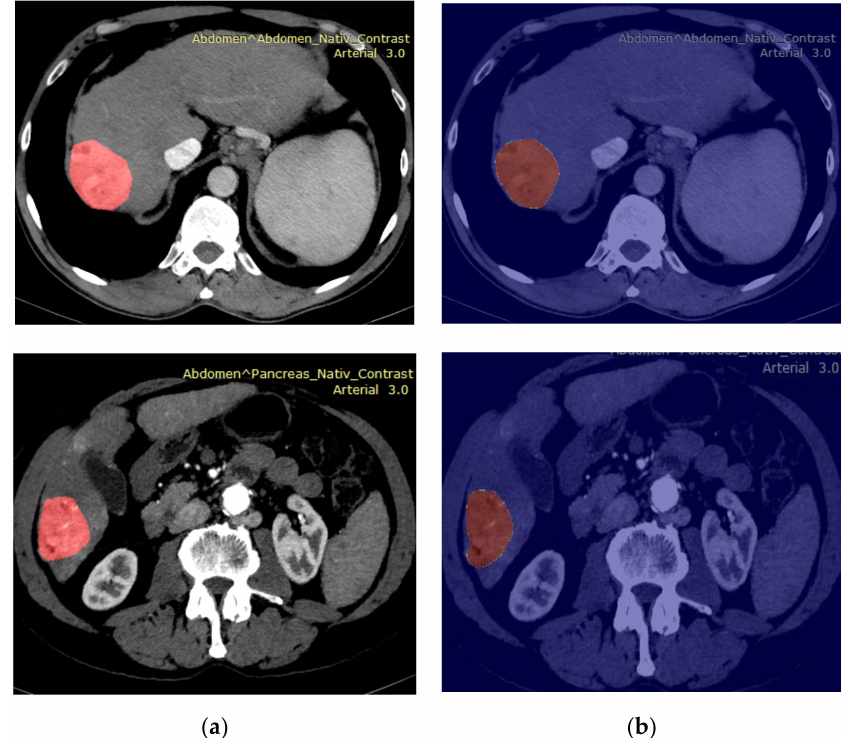
Figure 4. The probabilistic maps and the ground truth for the automatic hepatocellular carcinoma (HCC) segmentation within contrast-enhanced computerized tomography (CT) images: ( a ) the original images with the tumors depicted by the radiologists (the ground truth); ( b ) the automatically generated probabilistic maps (the red pixels denote an increased probability for the pixels that belong to the HCC class, while the blue pixels denote a low probability for the pixels that do not belong to this class).